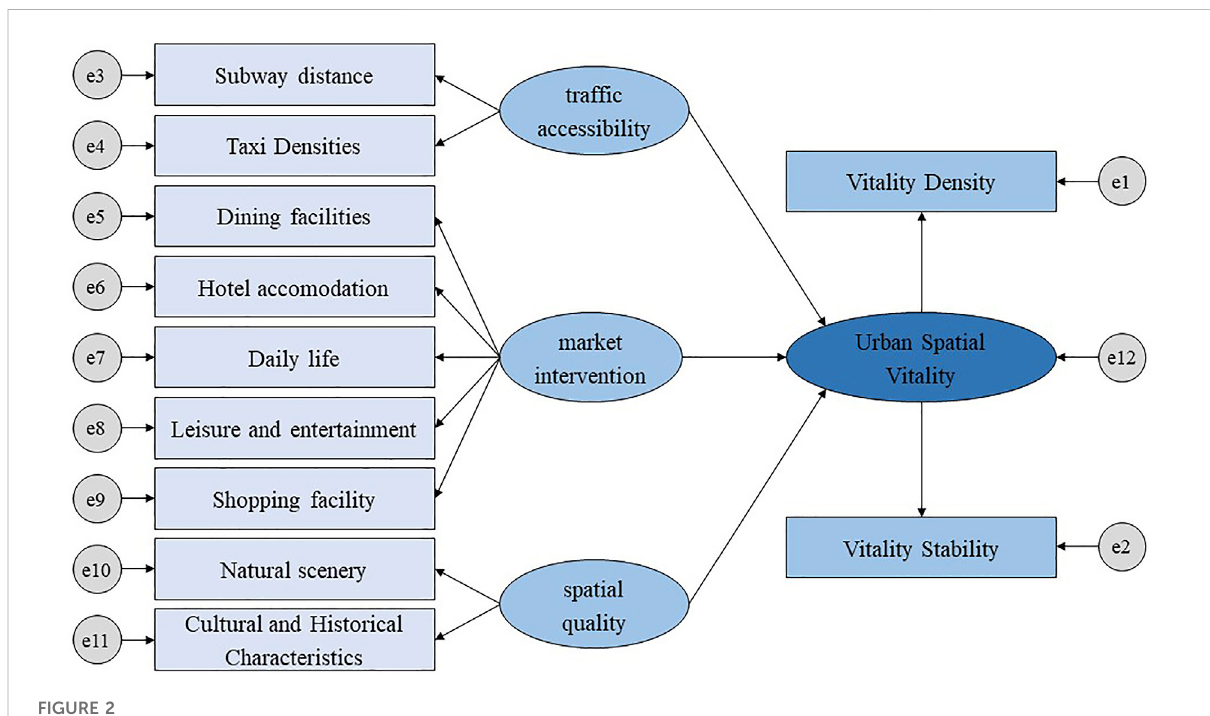
FIGURE 2 Conceptual structural